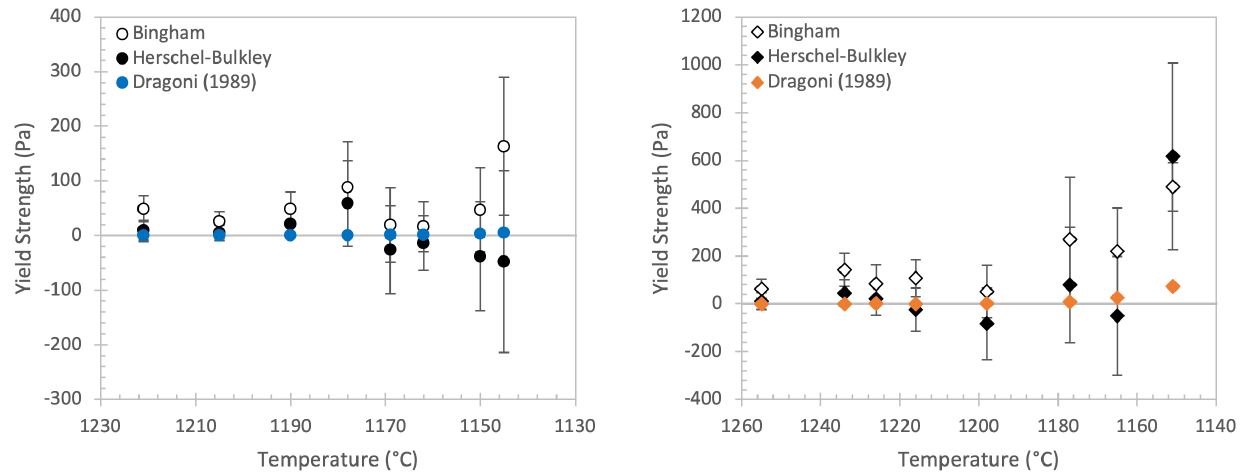
Figure 8: Apparent yield strength estimates for Nyiragongo (circles) and Nyamuragira (diamonds). Both Bingham (open) and Herschel-Bulkley (closed) fits were used and values were also calculated following Dragoni [1989] (colored). Error bars for these calculated values are smaller than the symbol